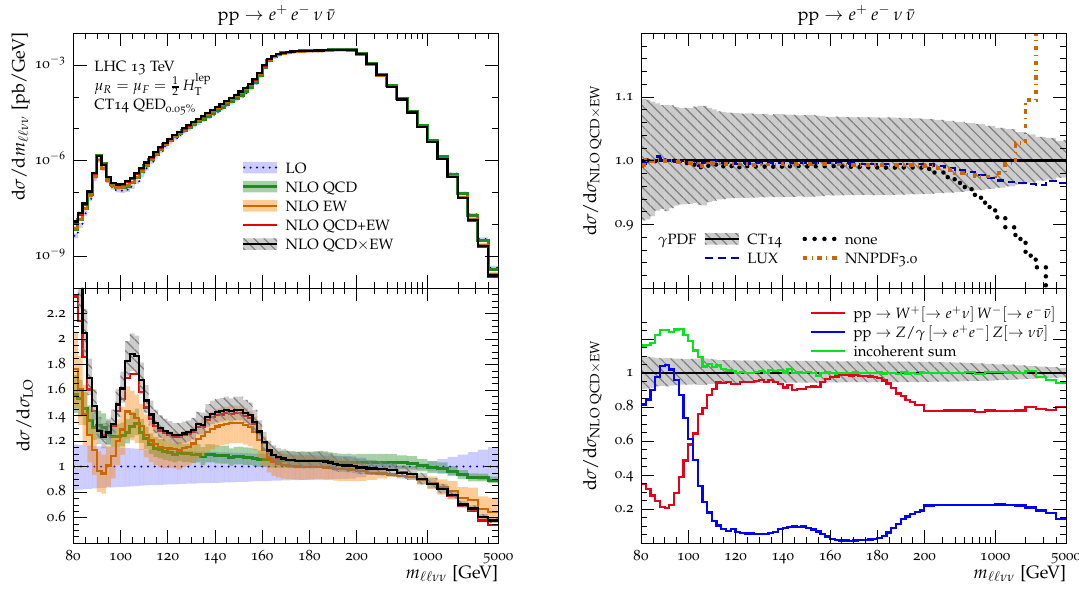
Figure 20 . Distribution in the invariant mass of one matching lepton-neutrino pair, m pp e + e (cid:0) (cid:23) (cid:22) (cid:23) at 13 TeV. Details as in (cid:12)gure 16. !